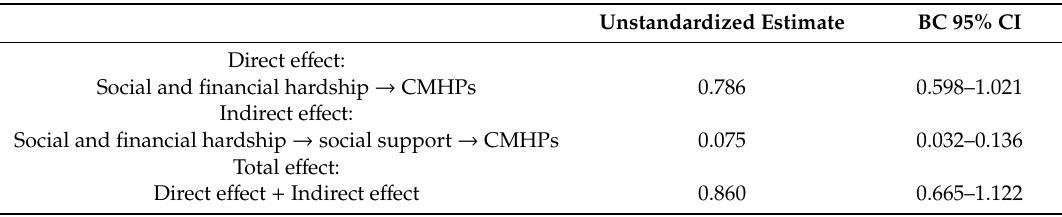
Table 4. Direct, indirect, and total e ff ect estimates and bias-corrected (BC) bootstrapped 95% CI of social and financial hardship on common mental problems